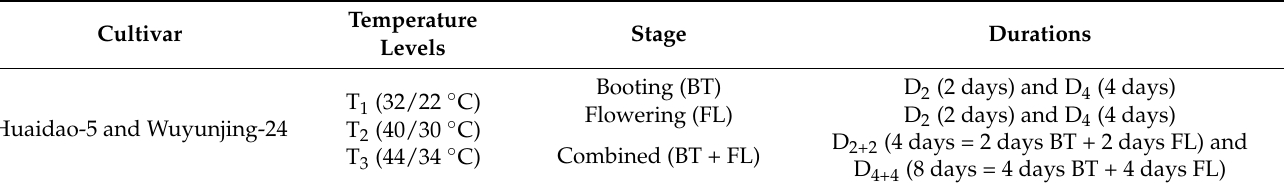
Table 1. Experimental